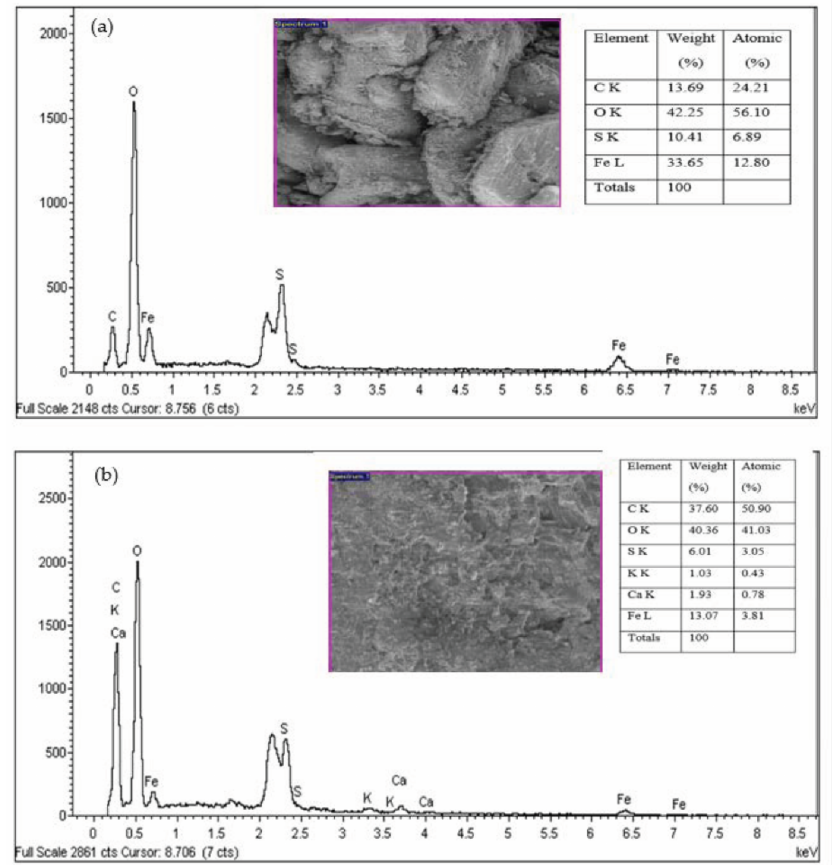
Figure 4. ( a ) SEM-EDX of FeSO 4 · 7H 2 O waste, and ( b ) generated sludge after SPRE treatment at optimized experimental